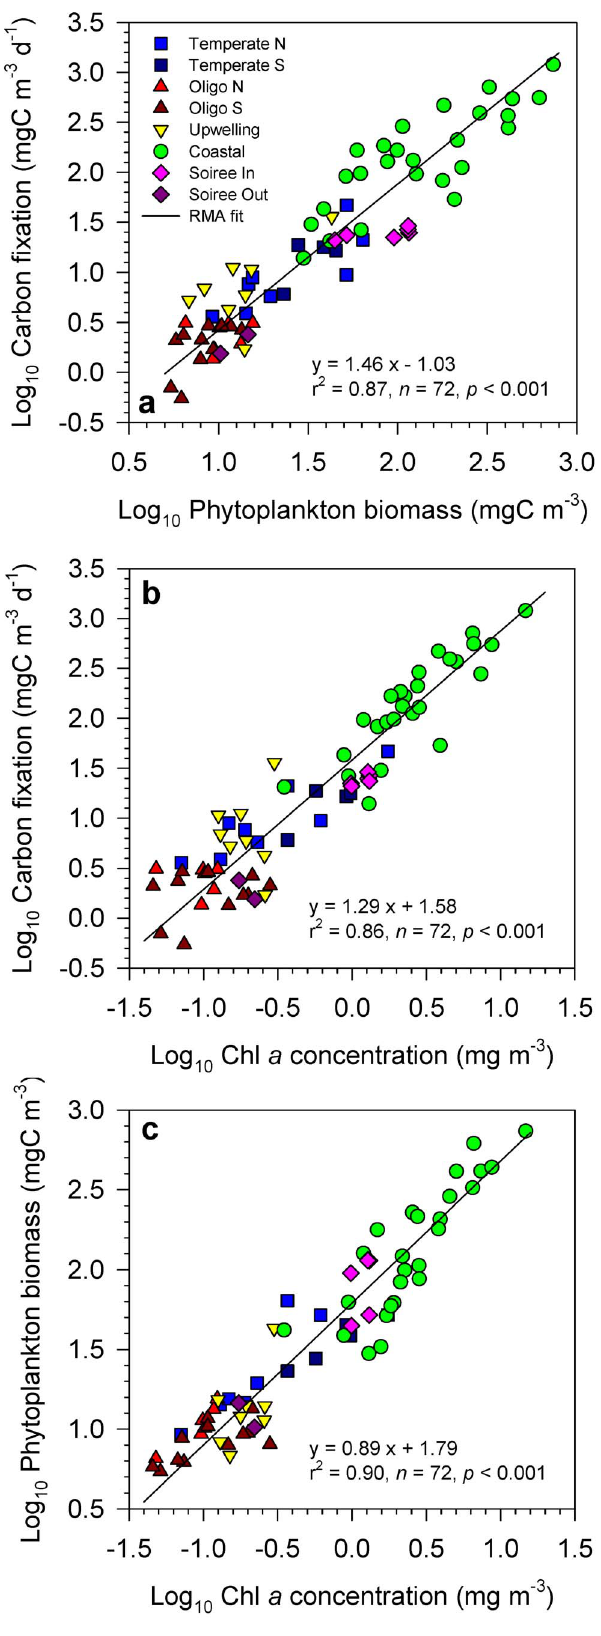
Figure 1. Phytoplankton chlorophyll a , biomass and produc- tion. Scatterplots showing the log-log relationship between (a) primary production and phytoplankton carbon biomass, (b) primary production and chlorophyll a concentration and (c) phytoplankton carbon biomass and chlorophyll a concentration. Different symbols indicate the sampling region as defined in the Methods section. ‘Soiree In’ and ‘Soiree Out’ refer to stations located inside and outside, respectively, the iron-fertilized patch during the Soiree study. Data were fitted to a linear model using reduced major axis